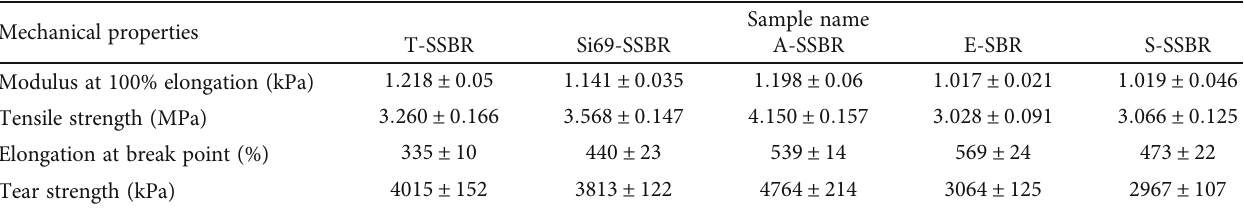
Figure 11: The stress – strain diagrams of the tensile test for the cured mixtures. Table 8: The mechanical properties of the cured mixtures from the tensile and rupture